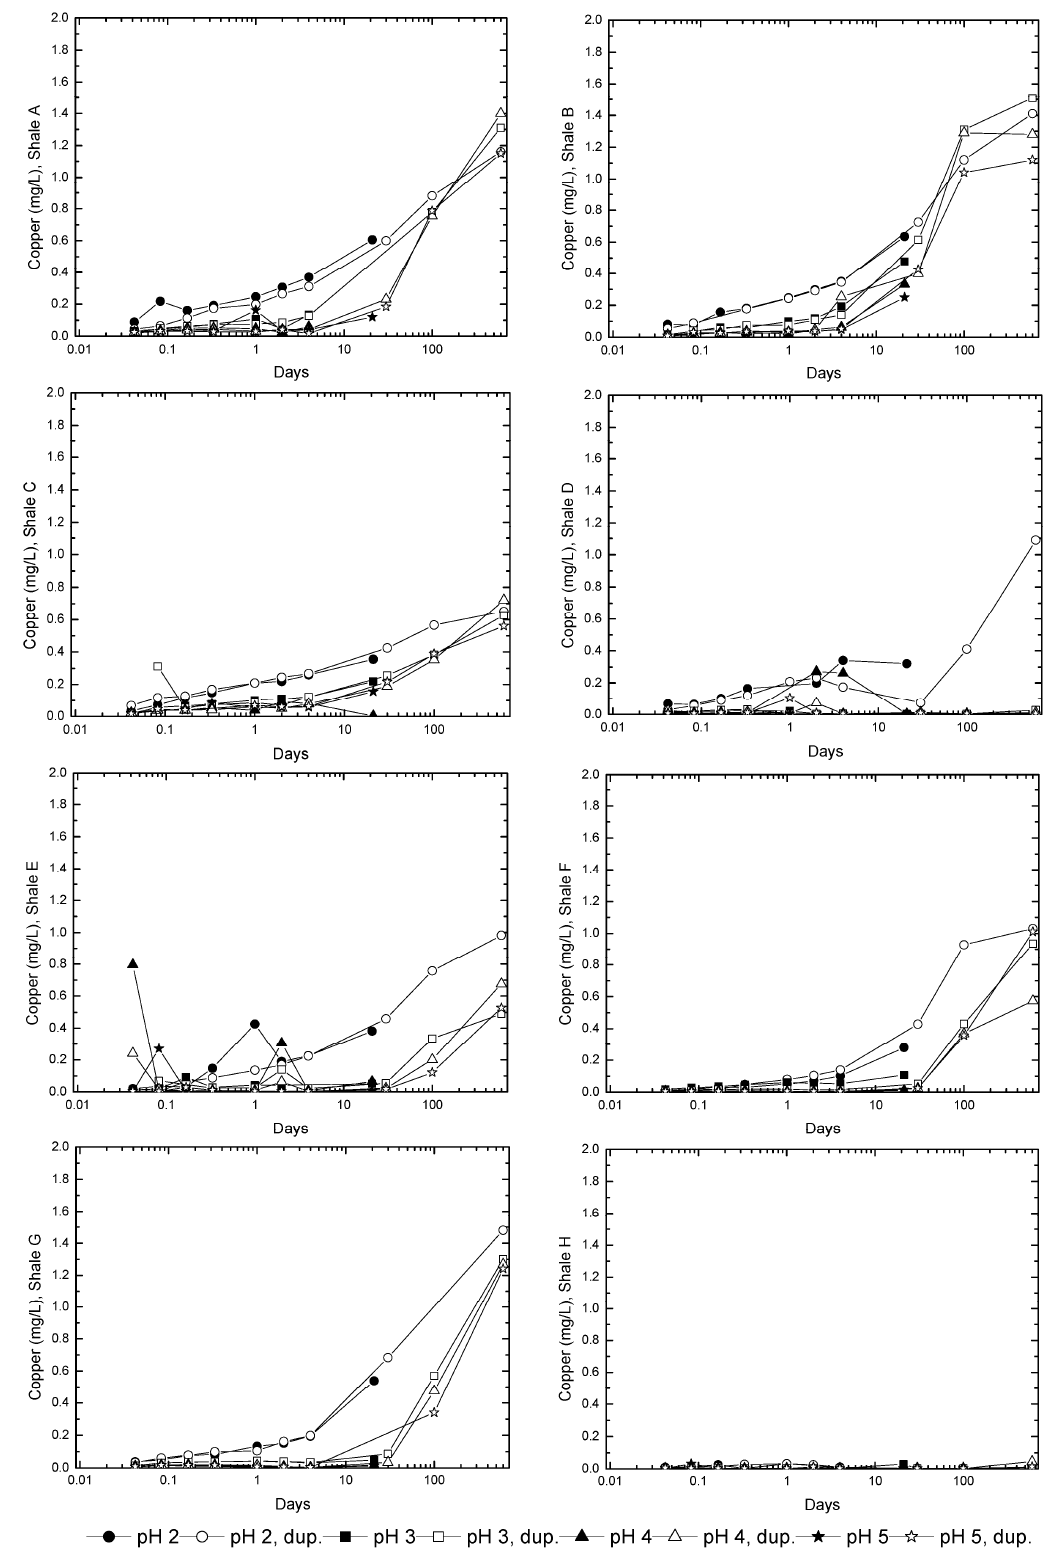
Figure 6. Solution Copper concentration recorded over time for all reaction vessels for all samples. Points on lines mark sample intervals from experiment commencement and 1, 2, 3, and 8 h, and 1, 2, 4, 21, 30, 100 and 600 days (logarithmic scale). The legend indicates initial sample